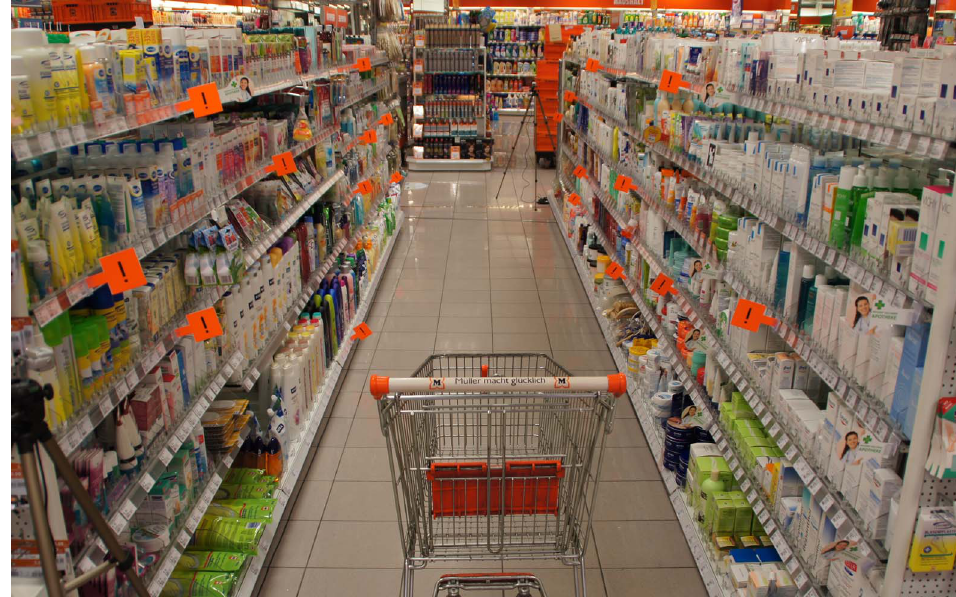
Figure 1. The drug store corridor with all marked special-offer products (orange signs) on two racks (each containing six shelves). Two cameras (marked by blue circles) at the beginning and the end of the corridor were used to record navigation of the subjects during the task.